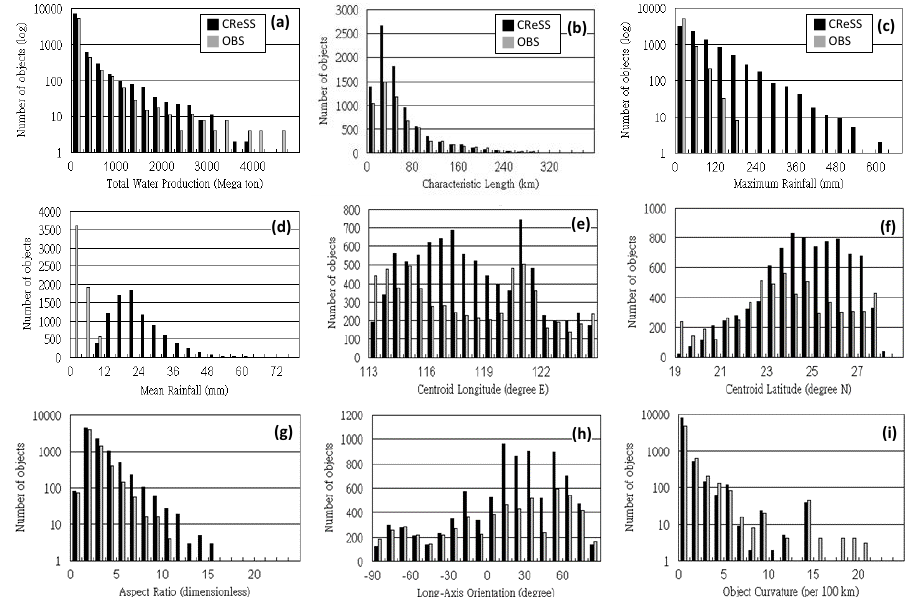
Figure 3. The distribution of number of objects as a function of ( a ) total water production (mega ton), ( b ) characteristic length (km), ( c ) maximum rainfall (mm), ( d ) areal-mean rainfall (mm), ( e ) centroid longitude ( ◦ E), ( f ) centroid latitude ( ◦ N), ( g ) aspect ratio (dimensionless), ( h ) long-axis orientation (degree), and ( i ) object curvature (10 −2 , or radius per 100 km) in the observation and CReSS QPFs at the range of 0–48 h, initialized twice daily at 00:00 and 12:00 UTC during South-West Monsoon Experiment (SoWMEX). The accumulation period is every 3 h, a total of 6081 and 8647 objects are identified in the observation and model forecasts, respectively. In panels ( a ), ( c ), ( g ) and ( i ), the logarithmic scale is used in the vertical axis.